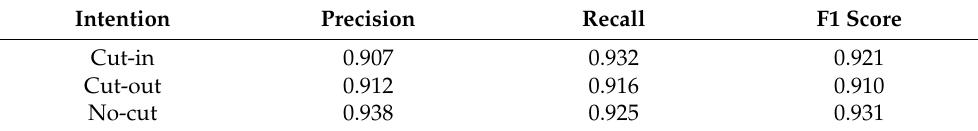
Table 2. Prediction results of VC-Attention.